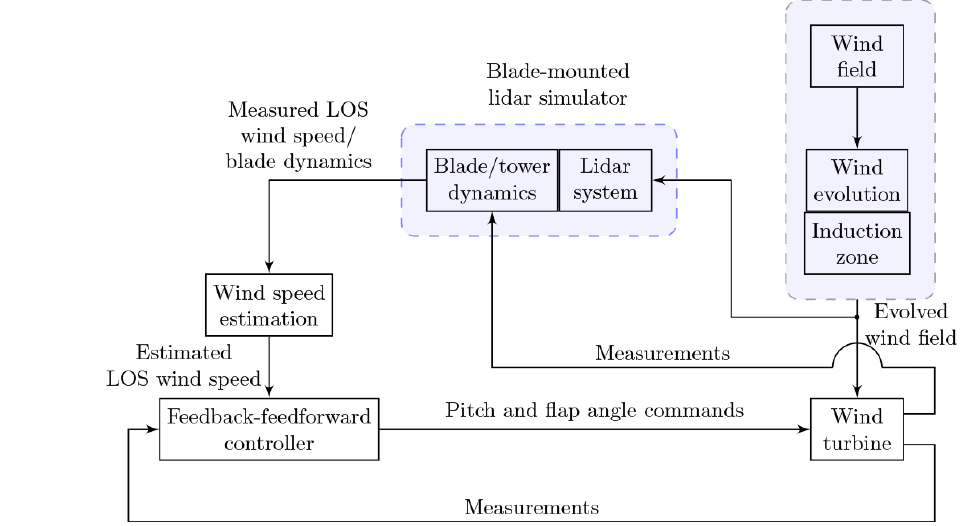
Figure 1. Block diagram of the blade-mounted lidar-based simulation set-up. LOS corresponds to line of sight.